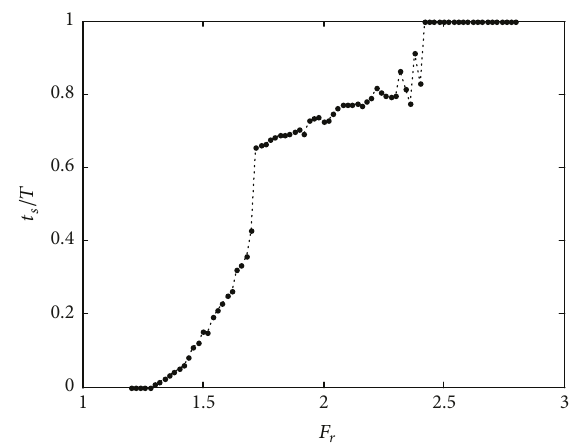
Figure 7: Sliding time duty